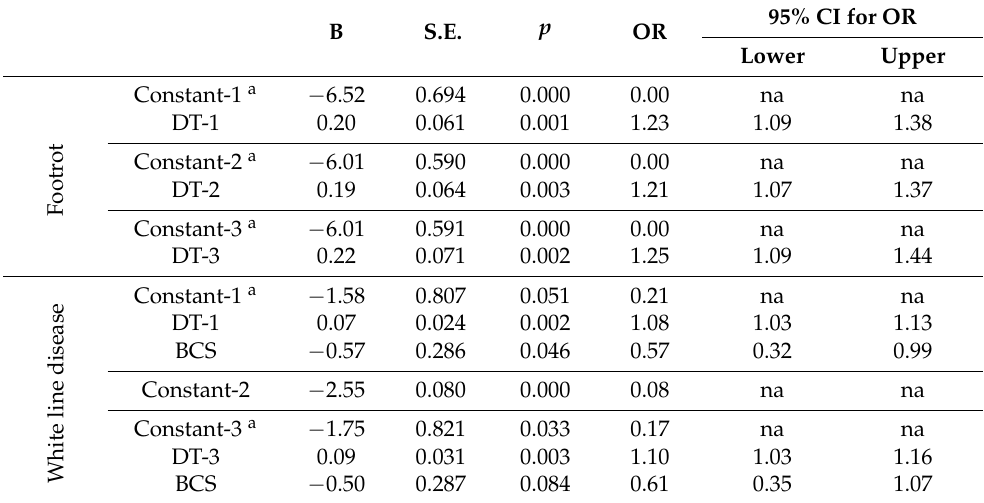
Table 2. Constants and regression coefficients of the predictor variables retained in the backwards stepwise regression models for the prediction of the occurrence of footrot and white line disease